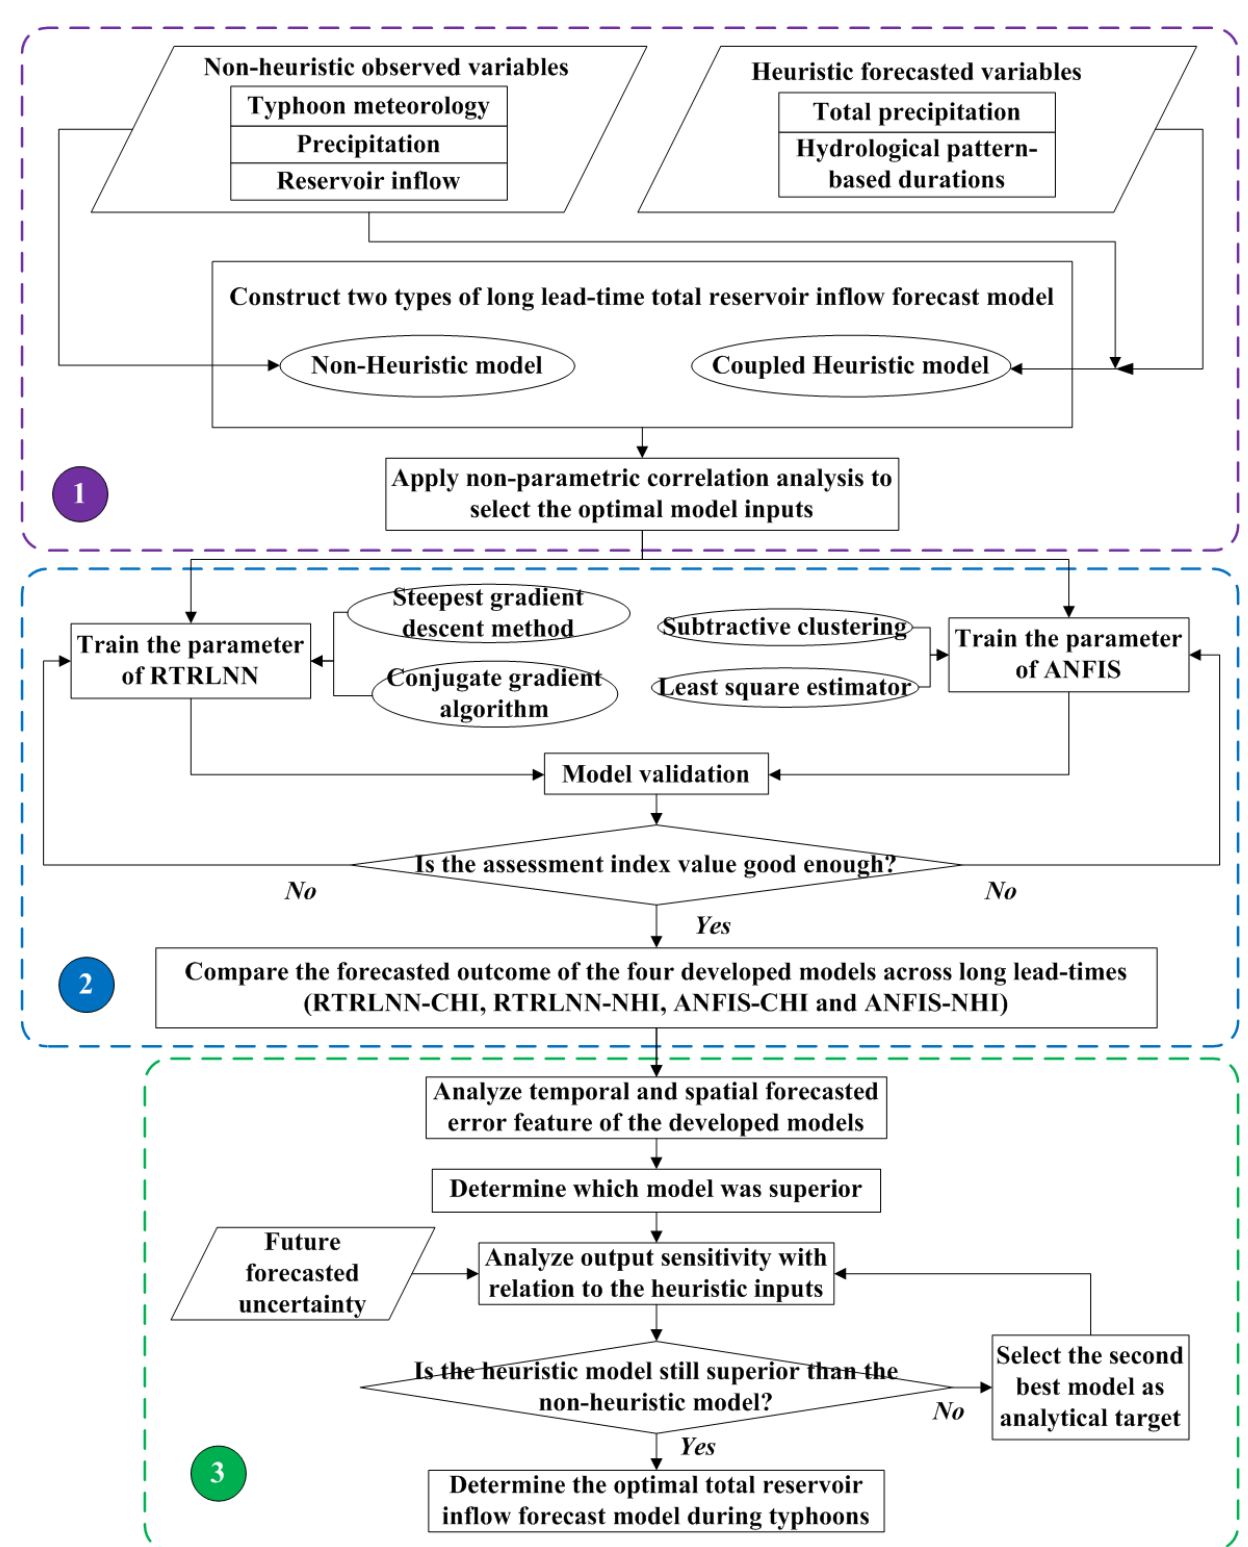
Figure 1. Flowchart of the